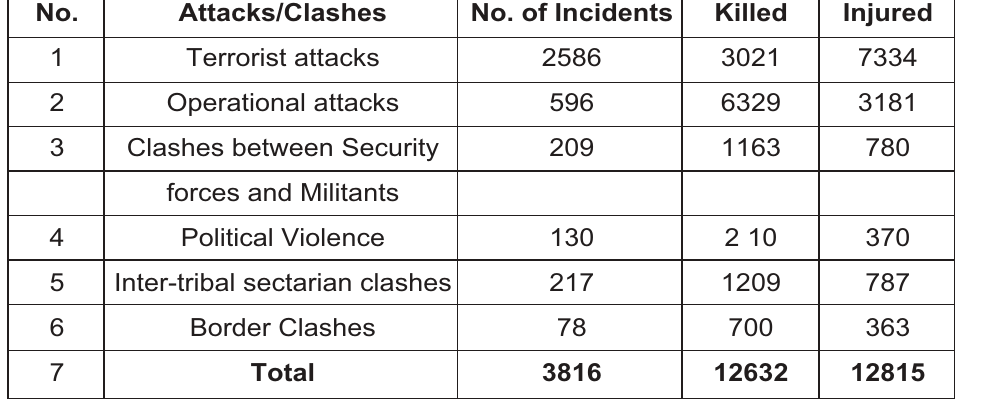
Table- 4 The Nature of Attacks during